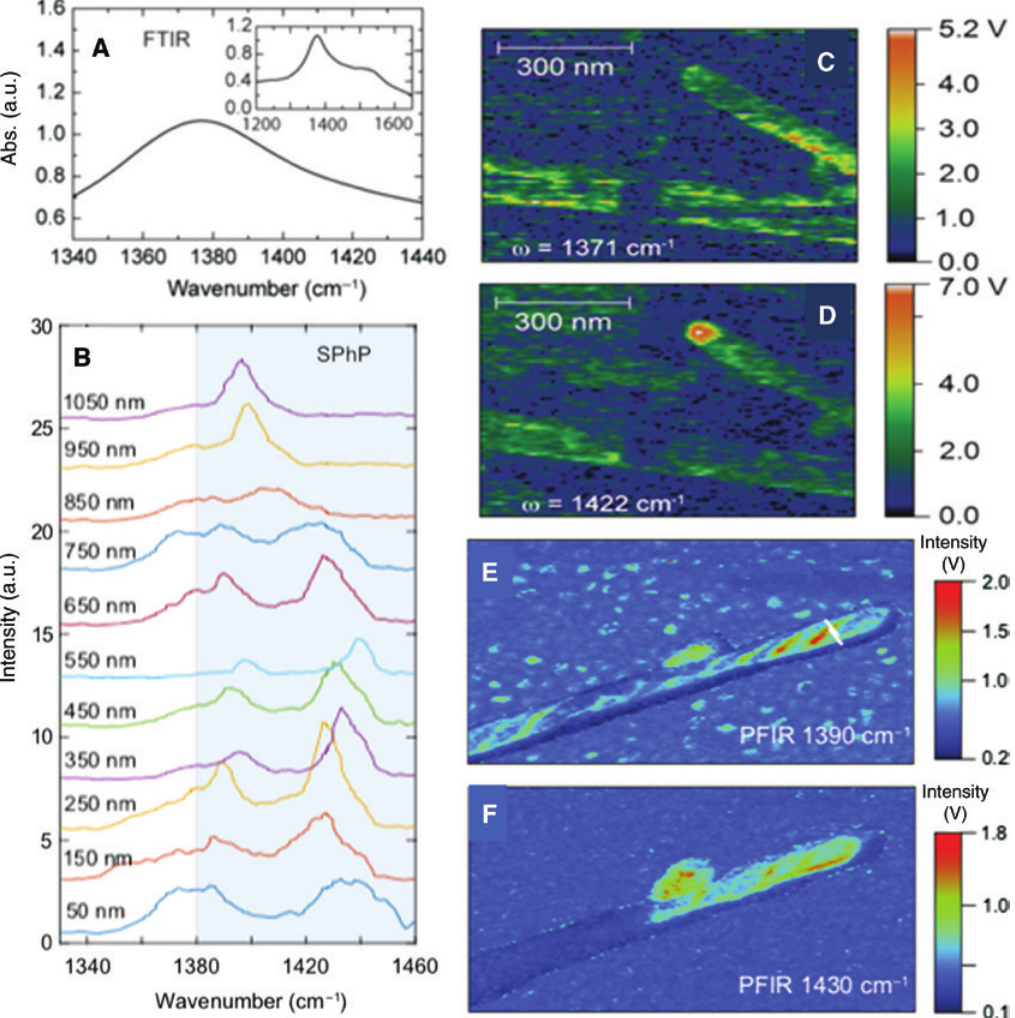
Figure 8: Spectrum and microscopy images of boron nitride nanotubes (BNNTs) [56, 64]. (A) FTIR spectrum of BNNTs; the inset shows a FTIR spectrum of a bigger range. (B) PFIR at different locations away from the BNNT terminal, showing the position-dependent surface phonon polariton resonances. (C–D) Nano-FTIR images of BNNTs at 1371 and 1422 cm −1 . (E, F)